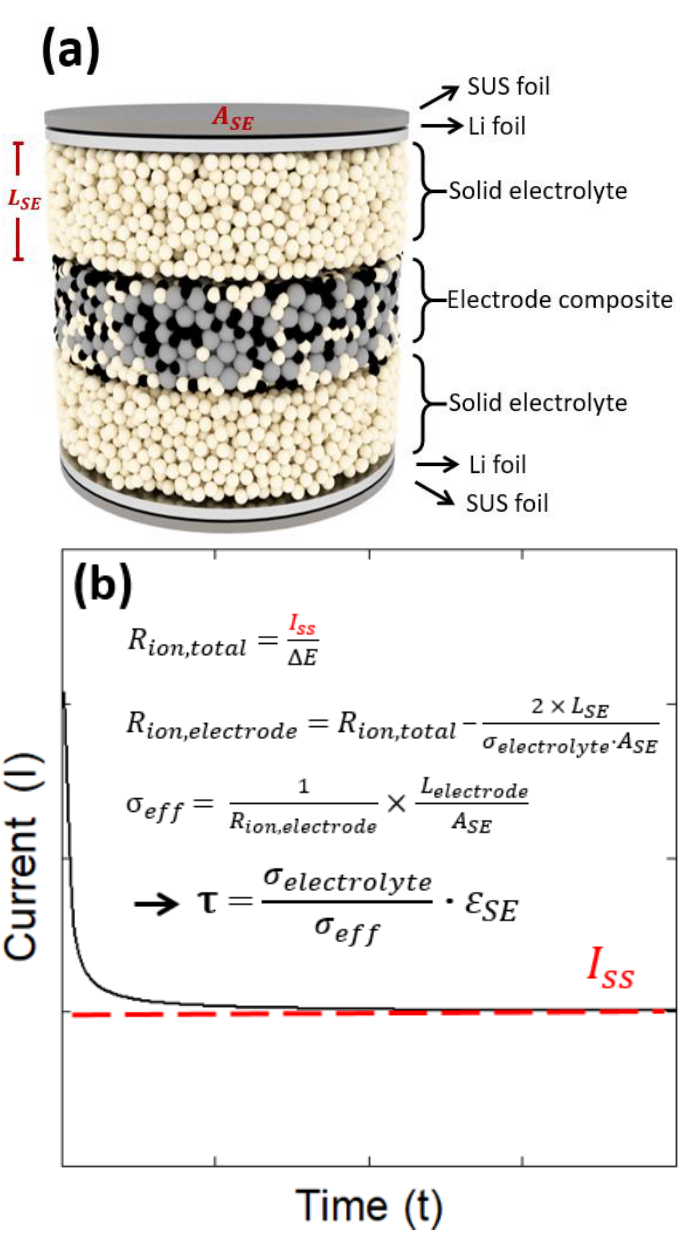
Figure 1. ( a ) Schematic diagram of an electron-blocking cell used for tortuosity analysis, and ( b ) hypothetical chronoamperometric curve showing steady-state current ( I ss ), together with the equations for tortuosity estimation.